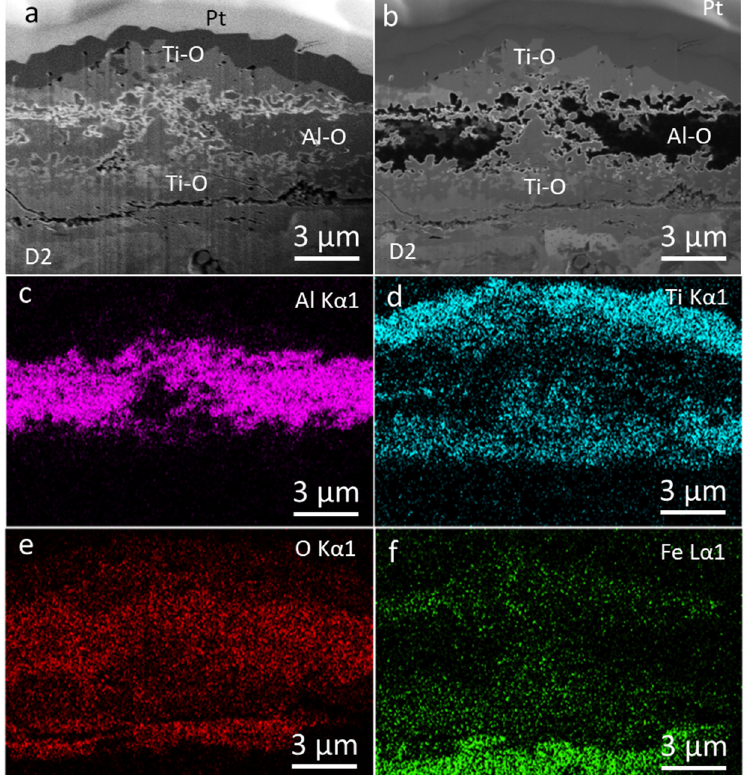
Figure 18. Conventional ( a ) and ion-generated ( b ) SEM images of FIB cross-section of sput- ter-deposited TiAlN hard coating oxidized at 850 °C for 120 min and corresponding elemental deposited TiAlN hard coating oxidized at 850 ◦ C for 120 min and corresponding elemental maps ( c – f maps ( c – f ).